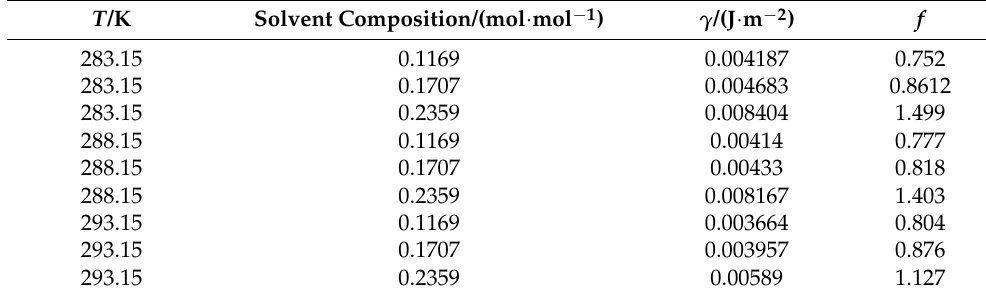
Table 2. The calculated results of interfacial tension and surface entropy factor. T